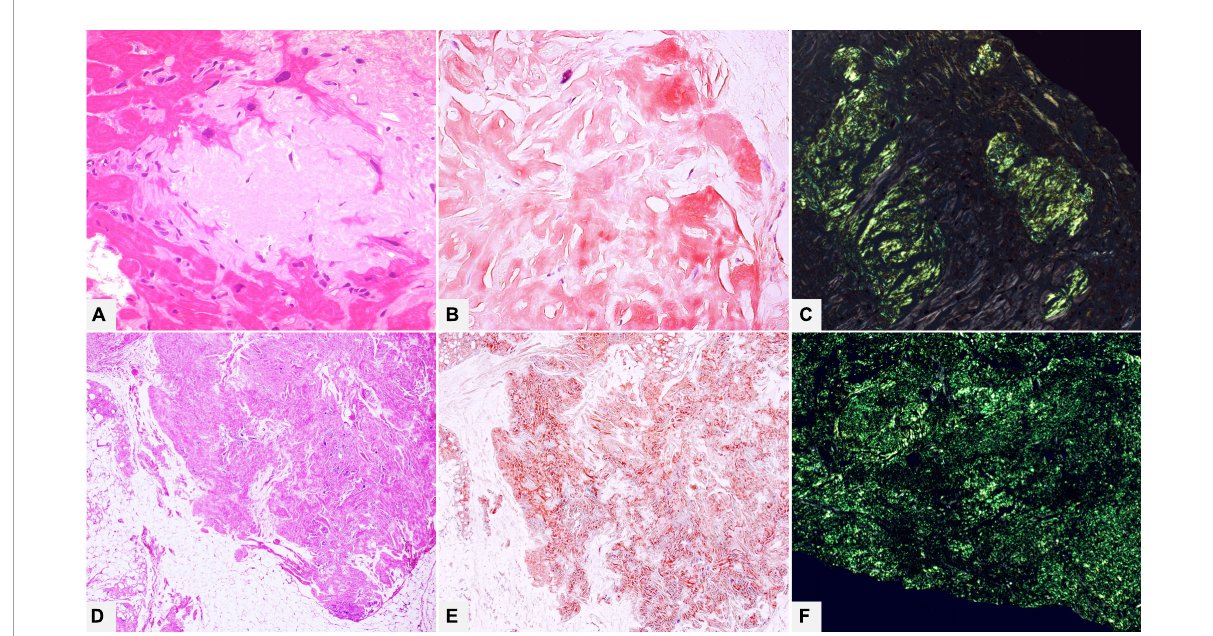
FIGURE2 (A–C) Endomyocardial biopsy of a 52-year-old male patient with monoclonal gammopathy of undetermined significance: histology shows interstitial myocardial nodular amyloid deposits. (D–F) Patient of 15 years suffering from type I diabetes with insulin replacement therapy, who underwent surgical removal of abdominal fibro-lipomatous mass with diffuse interstitial nodular amyloid deposits. With Congo red, amyloid appears orange-red when viewed under transmitted-light microscope (B,E) and shows brilliant green birefringence under polarized light (C,F) . (A) Hematoxylin-Eosin 400 × . (B) Congo red 400 × . (C) Congo red under polarized light 200 × . (D) Hematoxylin-Eosin 100 × . (E) Congo red 100 × . (F) Congo red under polarized light 200 ×